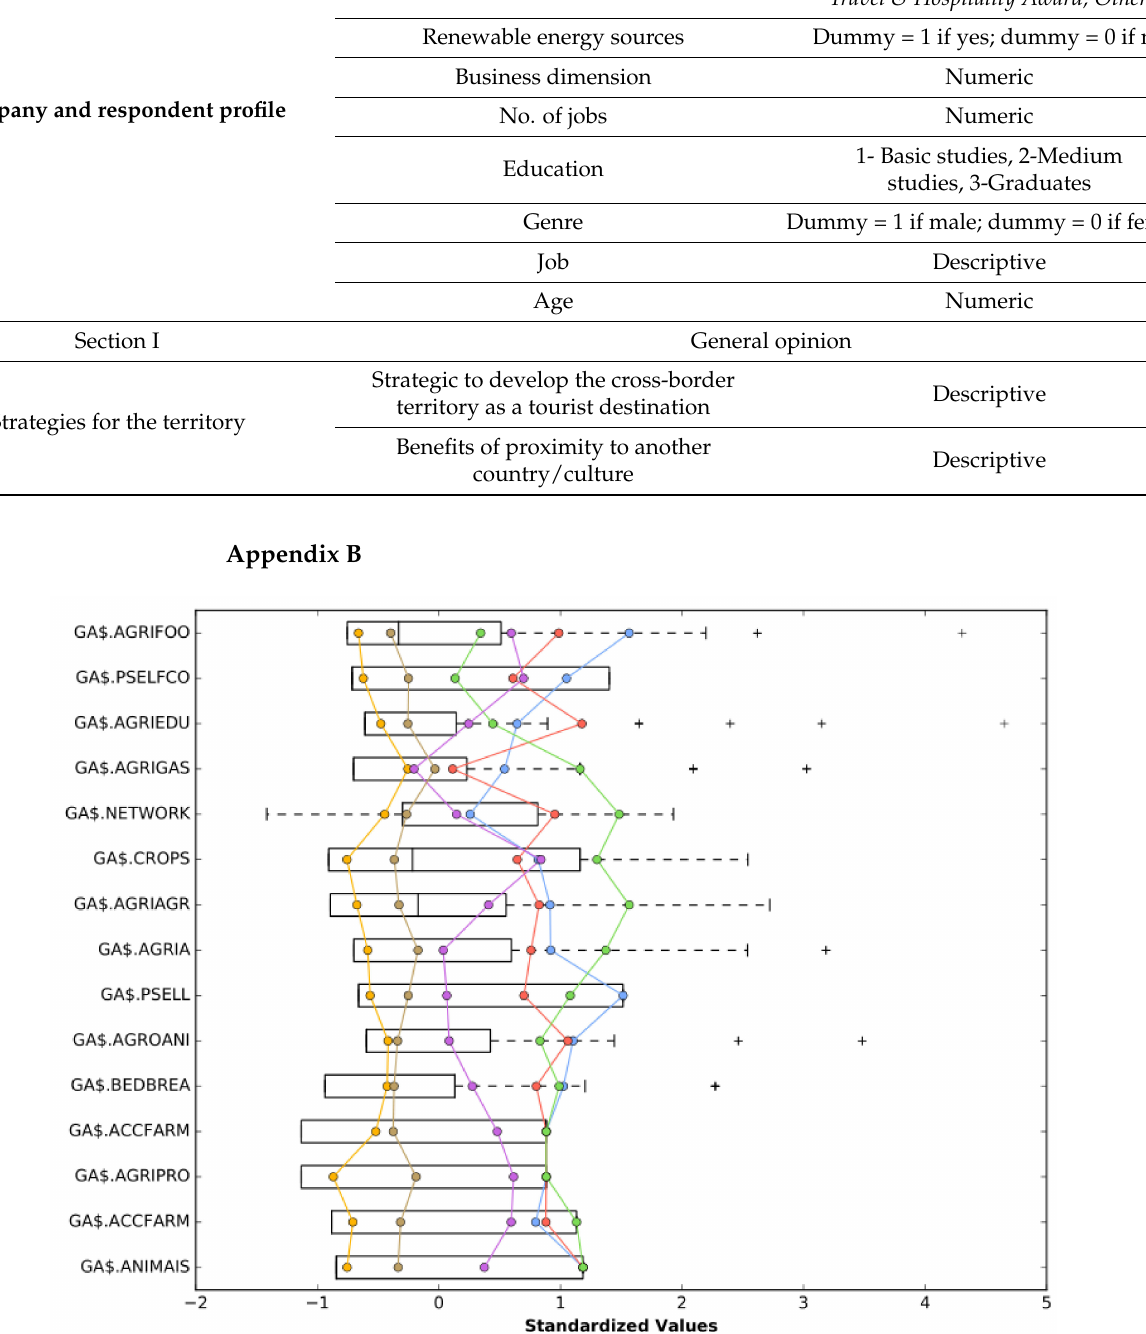
Figure A1. Parallel box plot obtained in Grouping Analysis using the ArcGIS